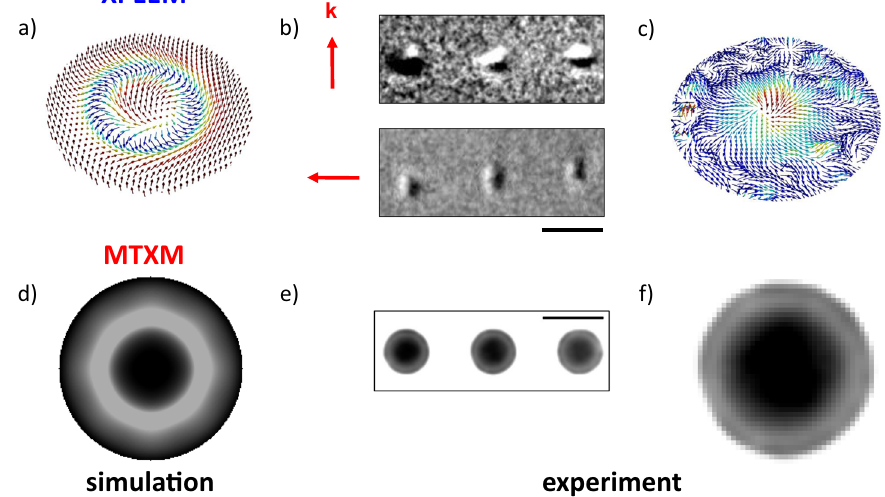
Fig. 2 Simulation and experimental results for X-PEEM and MTXM. a Simulation of the full 3D spin textures expected in X-PEEM. b Rows of three S30 nanodisks with 400-nm diameter observed with X-PEEM under θ = 0° and θ = 90°. c 3D spin texture reconstructed from experimental X-PEEM images. d Simulation of the MTXM image. e MTXM images of a row of three S30 nanodisks as in ( b ) showing a reproducible characteristic spin texture. f MTXM image of the identical disk as in ( c ). Color coding in ( a ) and ( c ): red points up, light-blue points down. Scale bars in ( b ) and ( e ) are 500 nm.